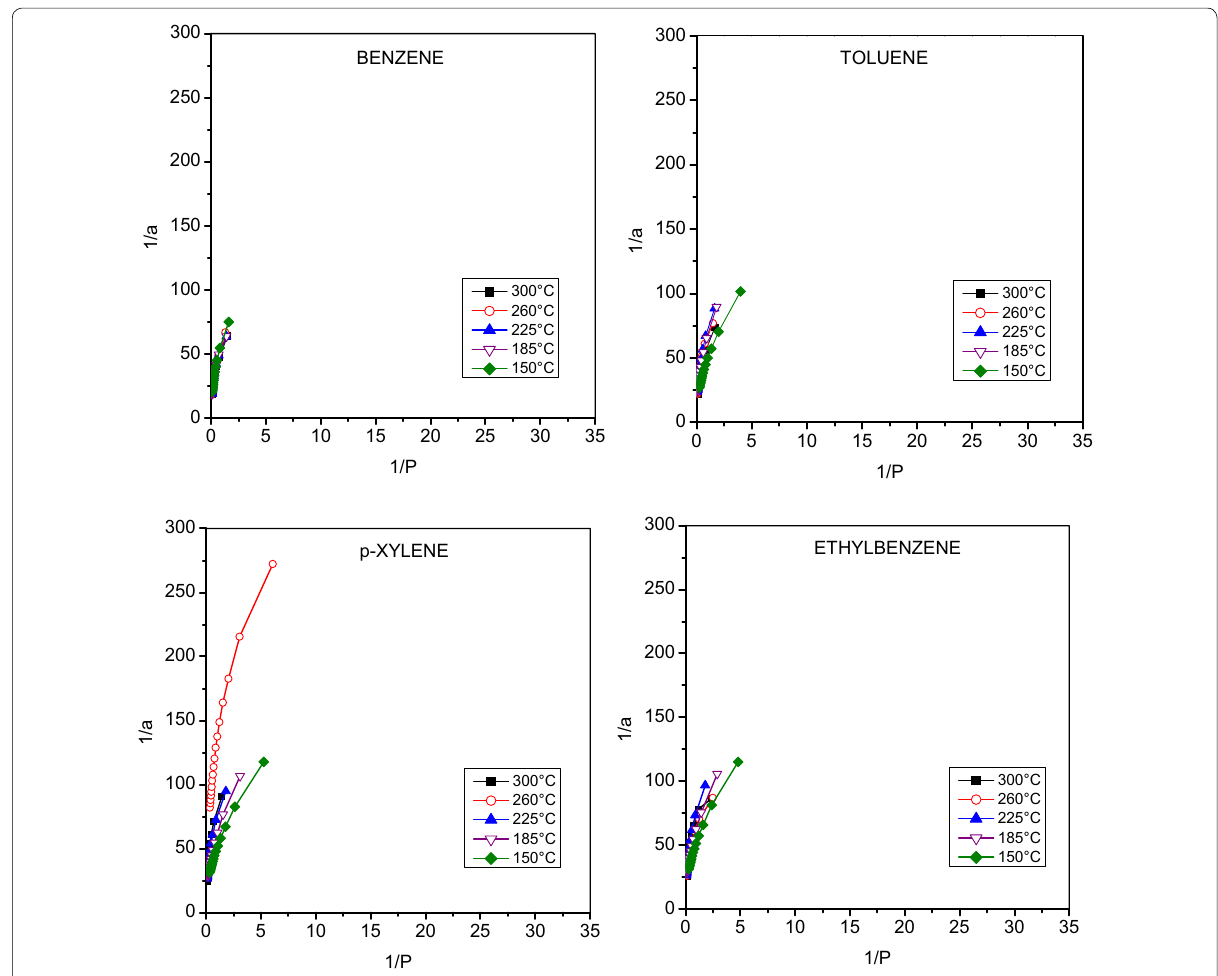
Fig. 10 Benzene, toluene, p ‑xylene, and ethylbenzene adsorption isotherms with the Langmuir model for